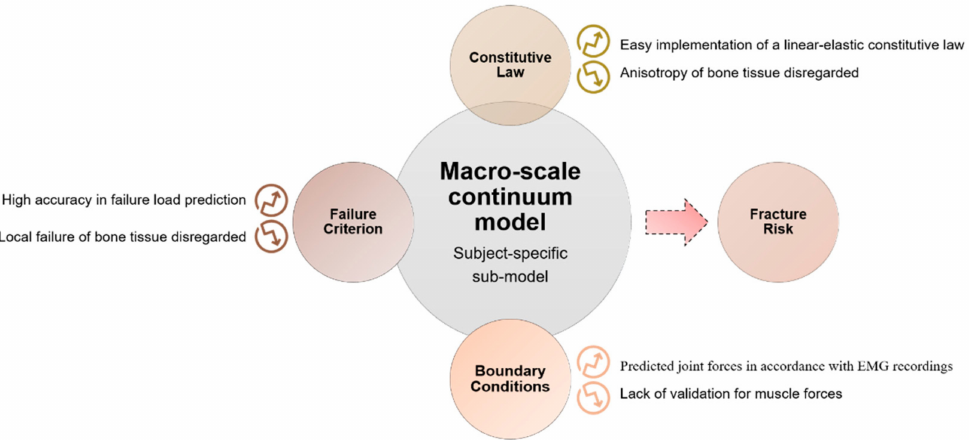
Figure 9. Scheme for the implementation of a whole-bone model. Results, potentialities and limitations are highlighted for each step. EMG: